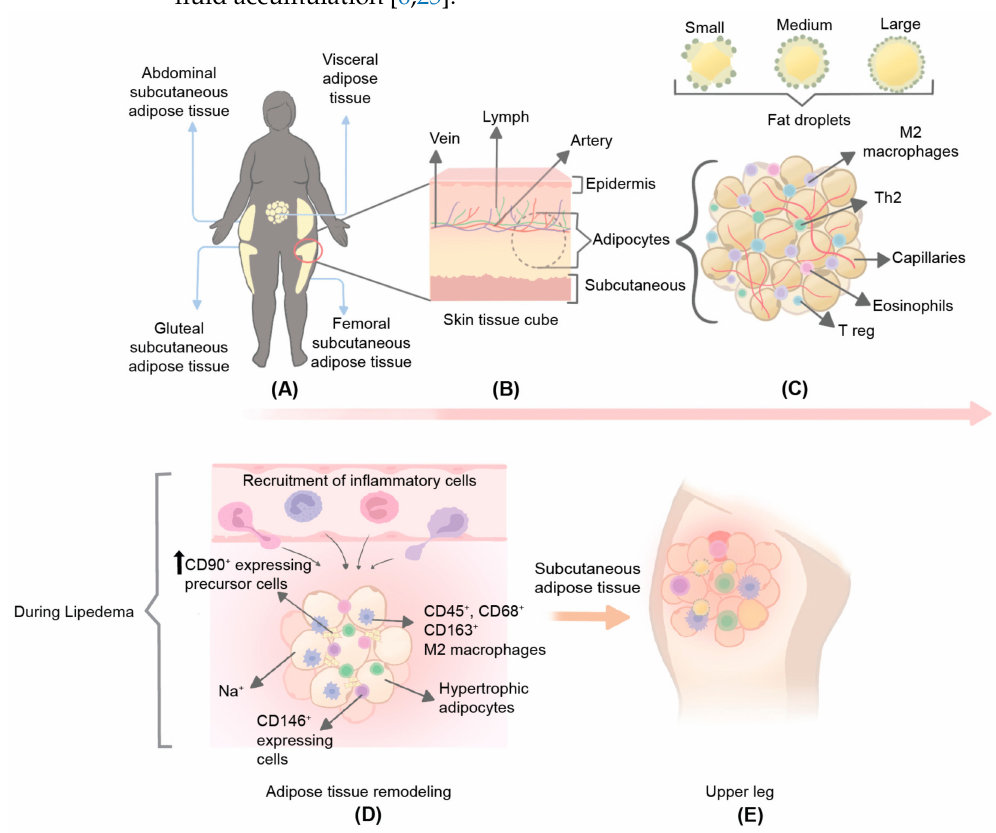
Figure 1. Representation of subcutaneous adipose tissue (SAT) characteristics pattern in lipedema. ( A ) The SAT location and deposition in the body; ( B ) skin tissue cube presenting their residing components; ( C ) characteristics of lean adipose tissue accompanied by ECM, immune cells, and various forms of typical fat droplets; ( D ) hypertrophy and hyperplasia in SAT with immune-cell requirements; and ( E ) inflammation, excessive fluid deposition, and swelling in the upper leg/thigh, which are the common characteristic of individuals with